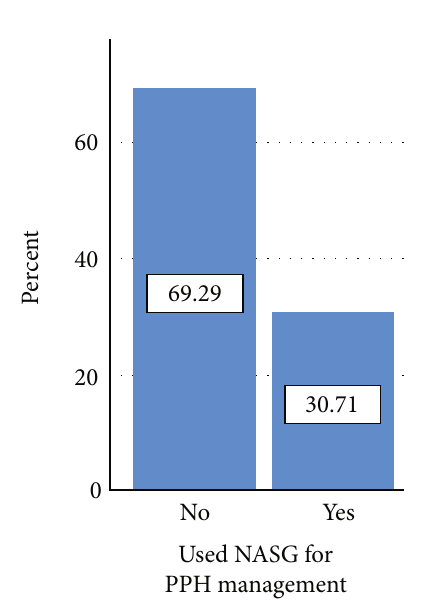
Figure 2: Utilization and nonutilization of NASG among obstetric care providers in public hospitals of Sidama region, Hawassa, Ethiopia, 2022.